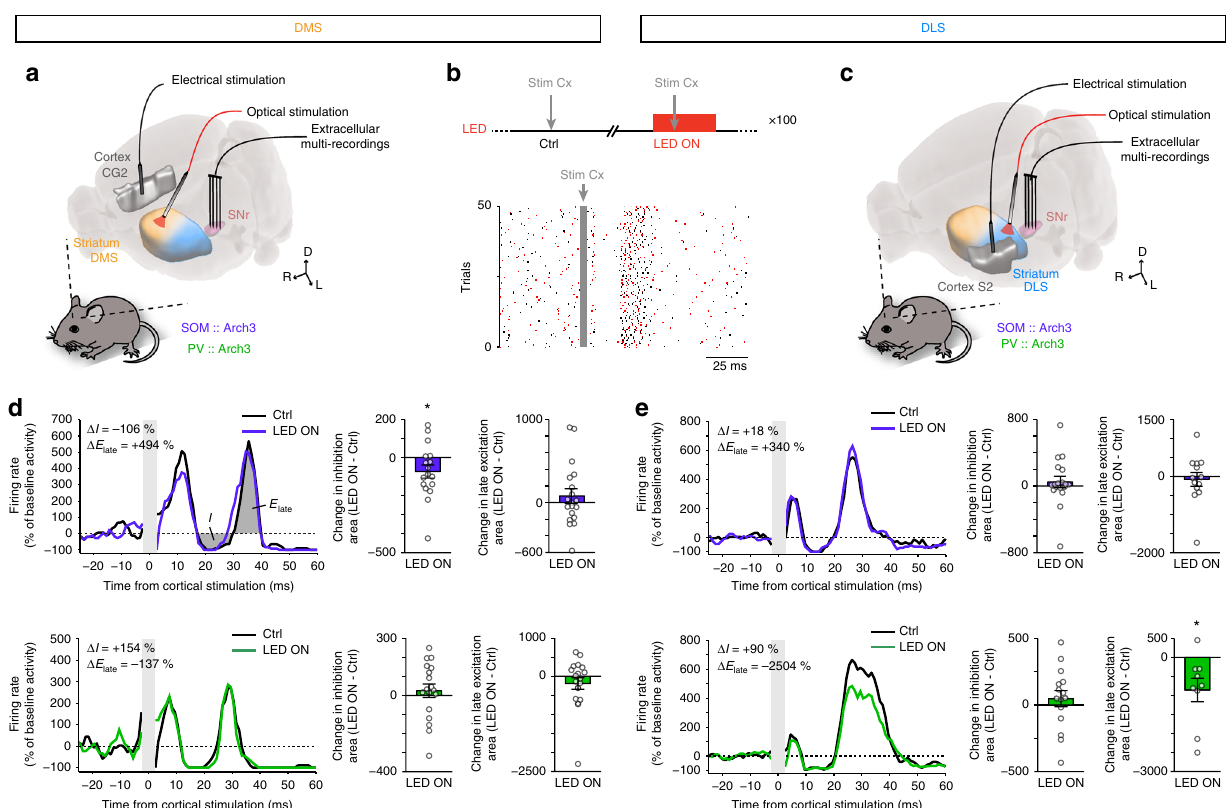
Fig. 8 Selective control of cortico-nigral information transfer by SOM and PV cells. a , c Experimental set up: in vivo multi-channel extracellular recordings of SNr unit activity using 4-shank 32-site silicon probe in response to stimulation in CG2 ( a ) or S2 ( c ) cortex, while PV or SOM interneurons are opto- inhibited using an optic fi ber implanted in the DMS ( a ) or DLS ( c ). b Top: A cortical stimulation is applied in the absence (left) or presence (right) of light (300 ms, 10 mW, stimulation 100 ms after light onset, cycle repeated at least 100 times, 2 – 6 s between trials). Bottom: Raster plot of a representative SNr unit recorded in the PV-DLS condition (unit in e bottom), showing the response to the cortical stimulation in interleaved Ctrl (black ticks) and LED ON (red ticks) trials. d , e Left: Activity of a representative SNr unit displaying a triphasic response upon cortical stimulation of CG2 ( d ) or S2 ( e ), in the absence of (Ctrl) or during the opto-inhibtion (LED ON) of SOM (top) or PV (bottom) interneurons in DMS ( d ) or DLS ( e ). The response is normalized to the baseline activity independently in each (Ctrl and LED ON) case. The measured areas of the trans-striatal phases (inhibition and late excitation) are illustrated in d , top, and the measured differences in area (LED ON – Ctrl) are indicated for each representative unit. Right: Change in response areas corresponding to the trans-striatal inhibition (left), and late excitation (right), in all units displaying the corresponding phase. The cortico-nigral inhibition phase is signi fi cantly reduced only by the opto-inhibition of SOM striatal interneurons in the DMS condition ( d , top, p = 0.0481, n = 17 units, paired t -test), while the cortico-nigral late excitation phase is signi fi cantly reduced only by the opto-inhibition of PV interneurons in the DLS ( e , bottom, p = 0.0237, n = 9 units, paired t -test); * p < 0.05. For the 3D images in a and c , brain and brain structures are captured from the Allen Institute for Brain Science ’ s Mouse